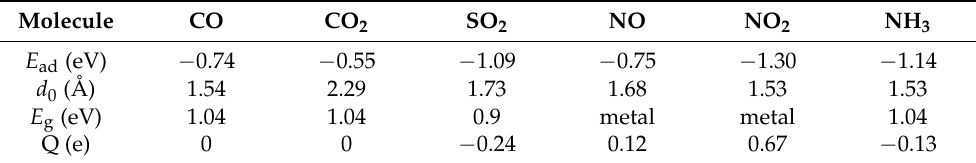
Table 1. The adsorption energy, equilibrium distance, energy band gap, and charge transfer for different gas molecules adsorbed on the ZnSiP 2